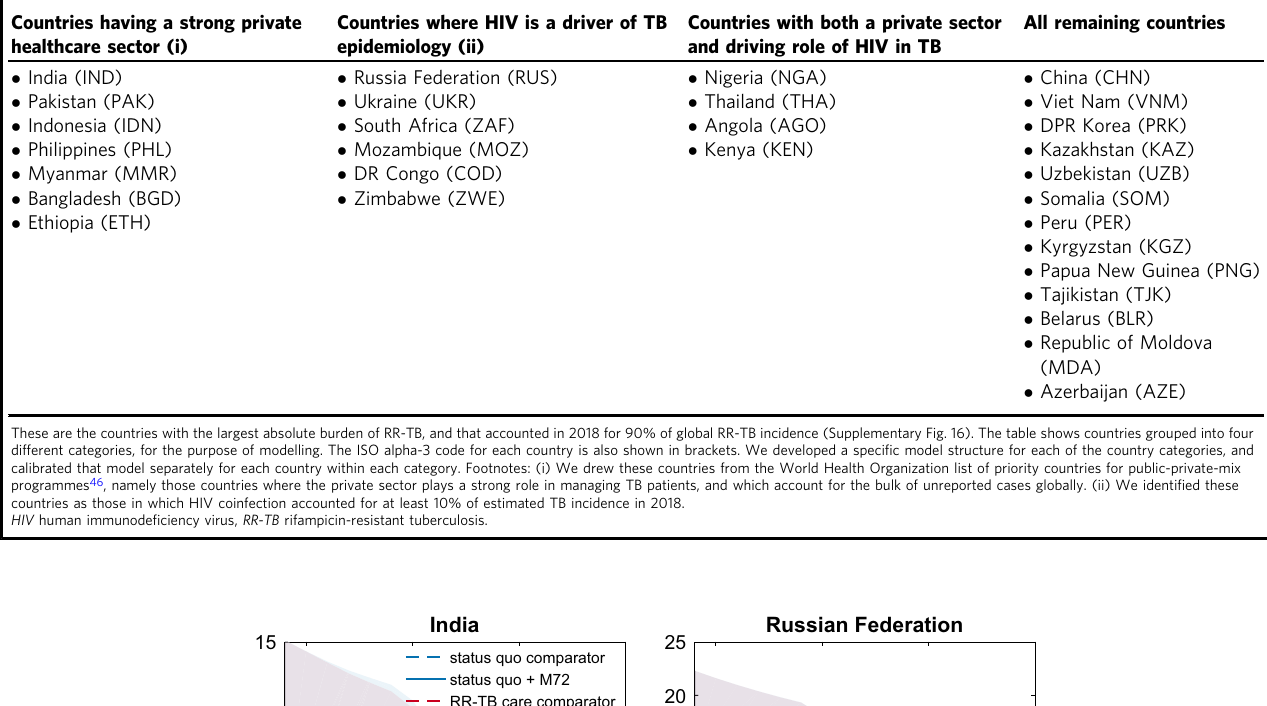
Countries with both a private sector and driving role of HIV in TB (cid:129) Nigeria (NGA) (cid:129) Thailand (THA) (cid:129) Angola (AGO) (cid:129) Kenya (KEN)